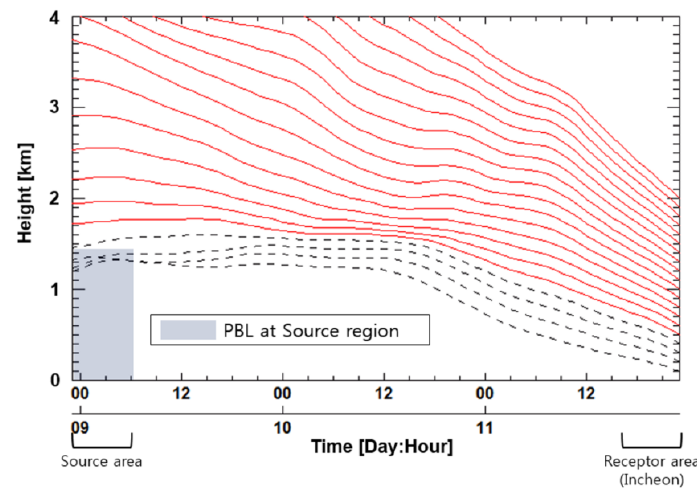
Figure 5. Example of the vertical distribution of three-day HYSPLIT backward trajectories for air masses arriving in Incheon on 11 February 2006 (Local Time).